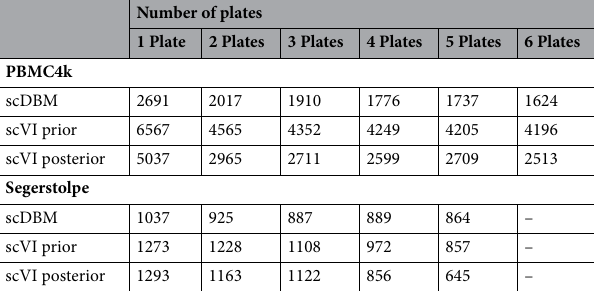
Table 1. Mean of absolute differences in the number of cells across all clusters.